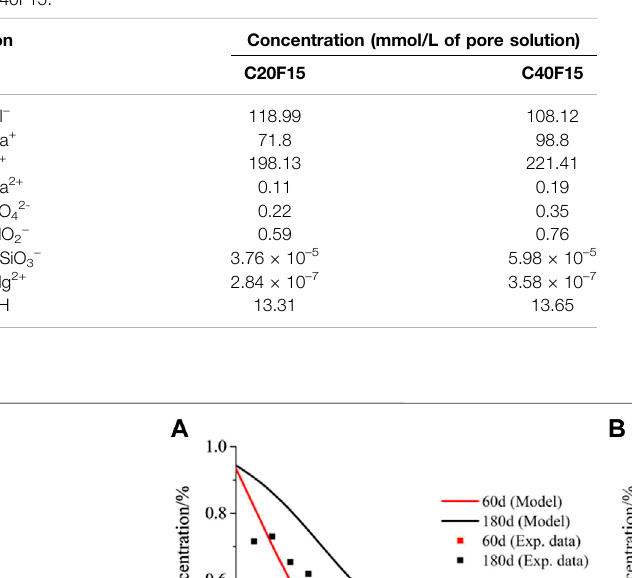
Frontiers in Materials |